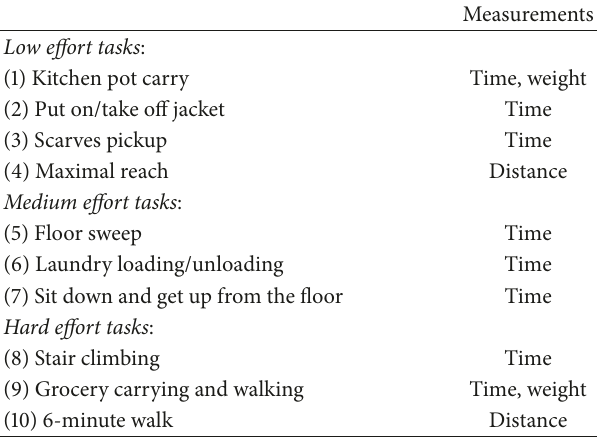
Table 1: Continuous-Scale Physical Functional Performance 10 Test—tasks and